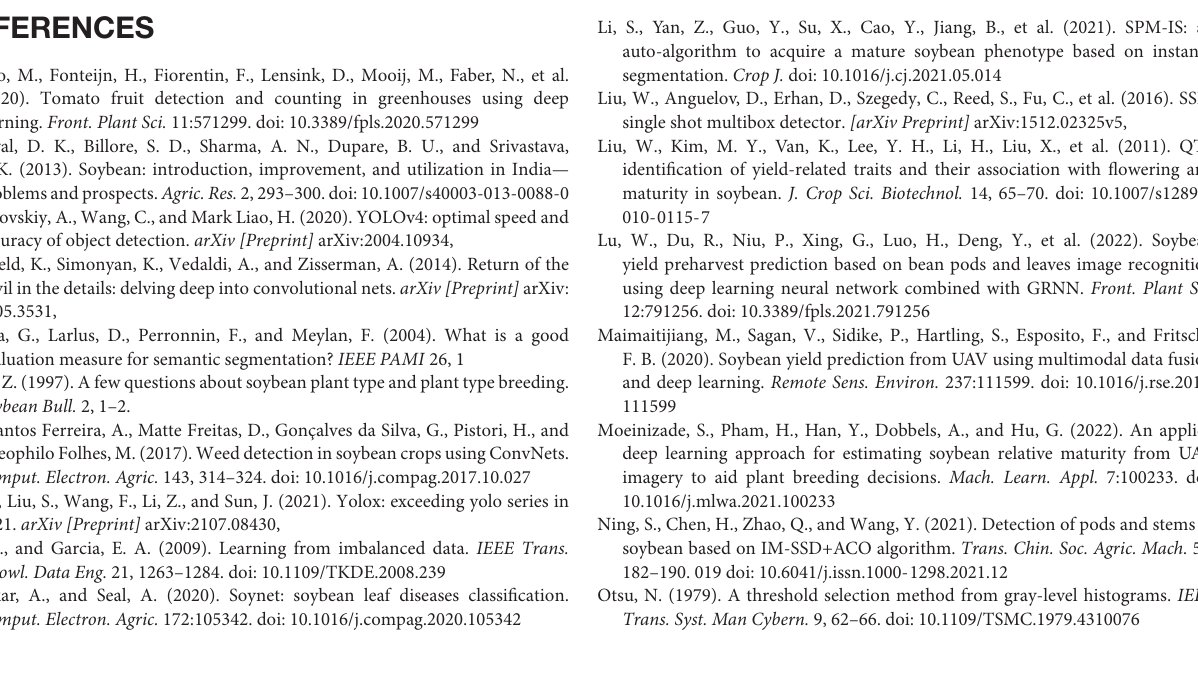
Supplementary Figure 1 | Angle analysis of three adjacent stem nodes on branches of soybean plants. Supplementary Figure 2 | Rectangular selection area extended pixel